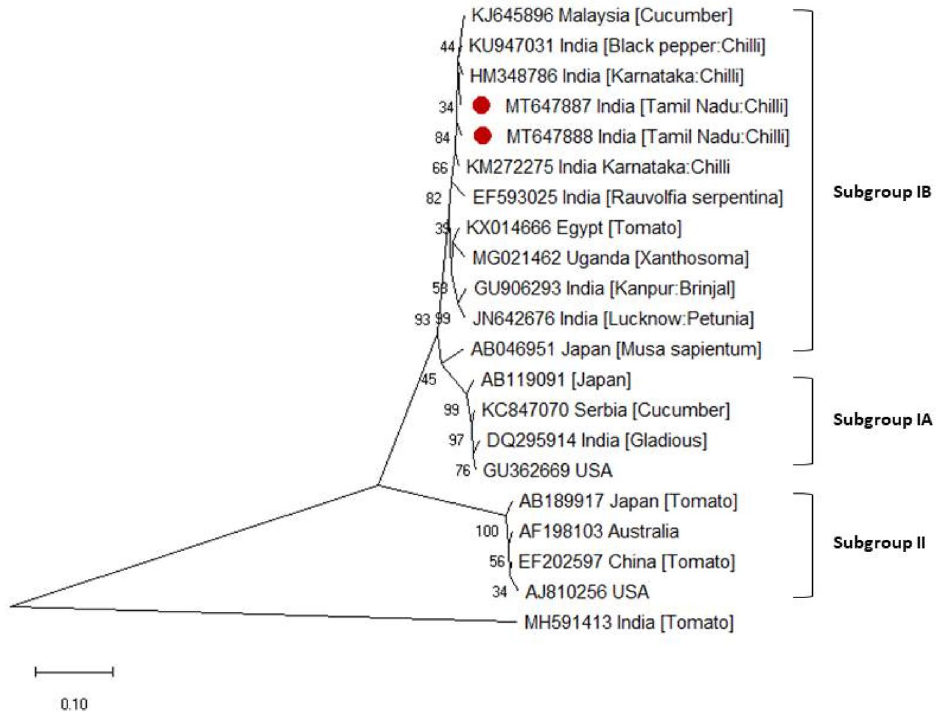
Figure 6. Phylogenetic relationship of CMV isolates of Tamil Nadu with other CMV isolates reported worldwide based on coat protein gene. Phylogenetic tree generated using MEGA 7 software using Neighbor joining tree method with 1000 replicates and GBNV (MH591413) isolate used as out